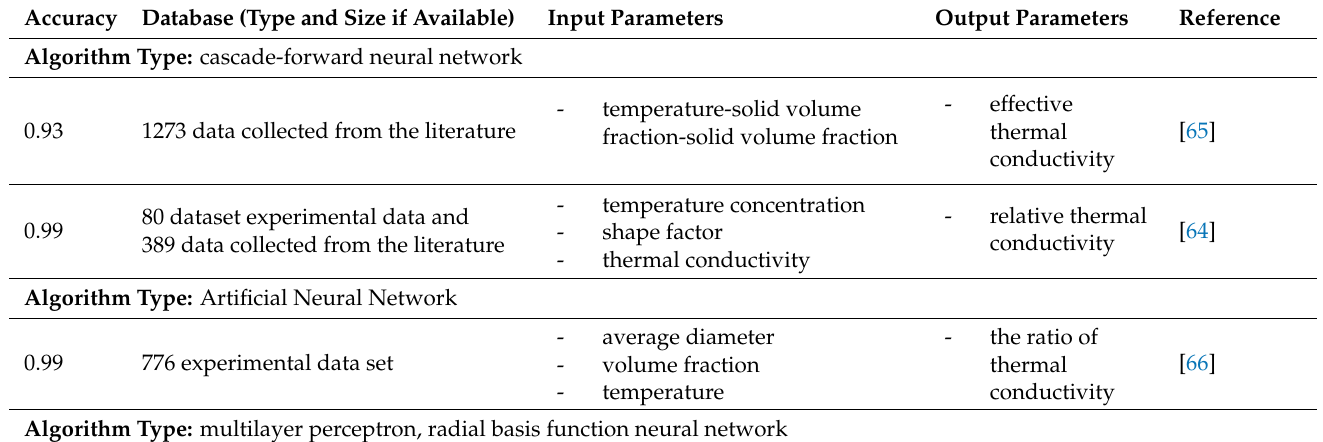
Table 2. The comparison of the algorithm’s performance takes account of effective thermal